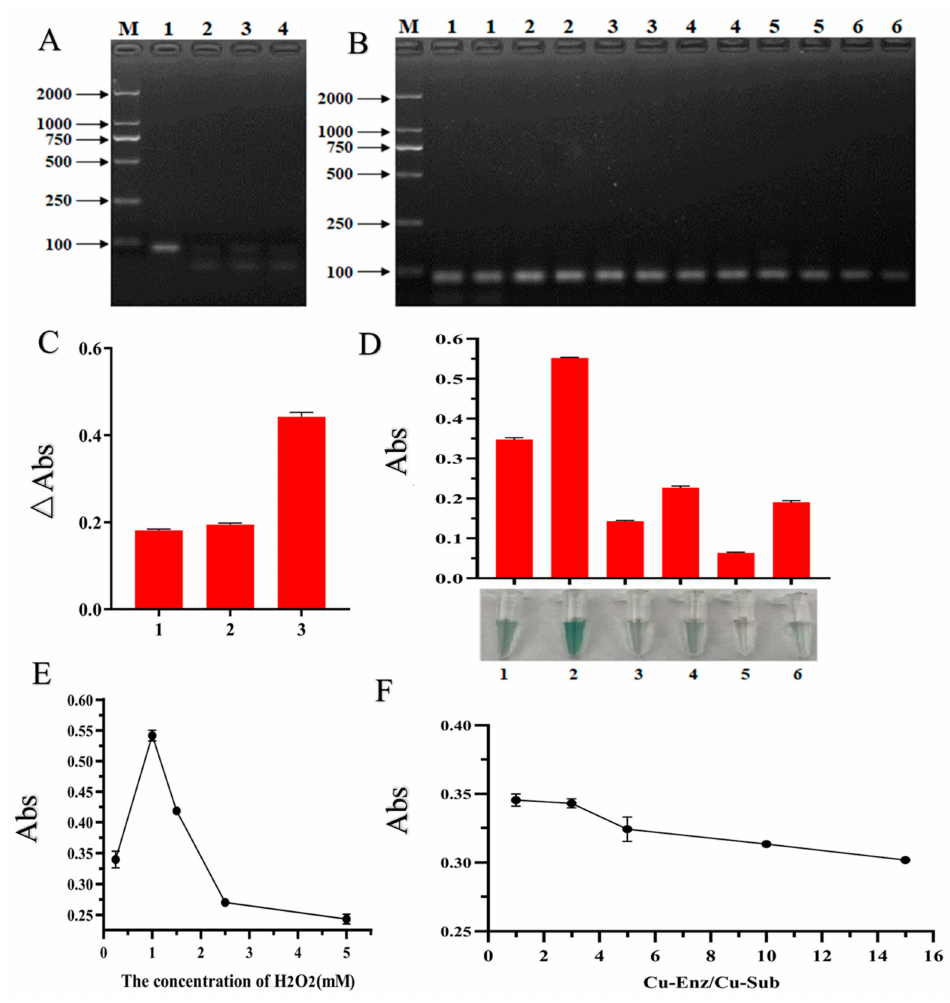
Figure 2. The results of the system optimization. ( A ) Optimization of cleavage time. M: DL 2000 (DNA Marker); 1: 0 min; 2: 30 min; 3: 60 min; 4: 90 min. ( B ) Optimization of ligation probe concentration. The concentration of the probes was diluted tenfold from 10 to 0.0001 µ M. M: